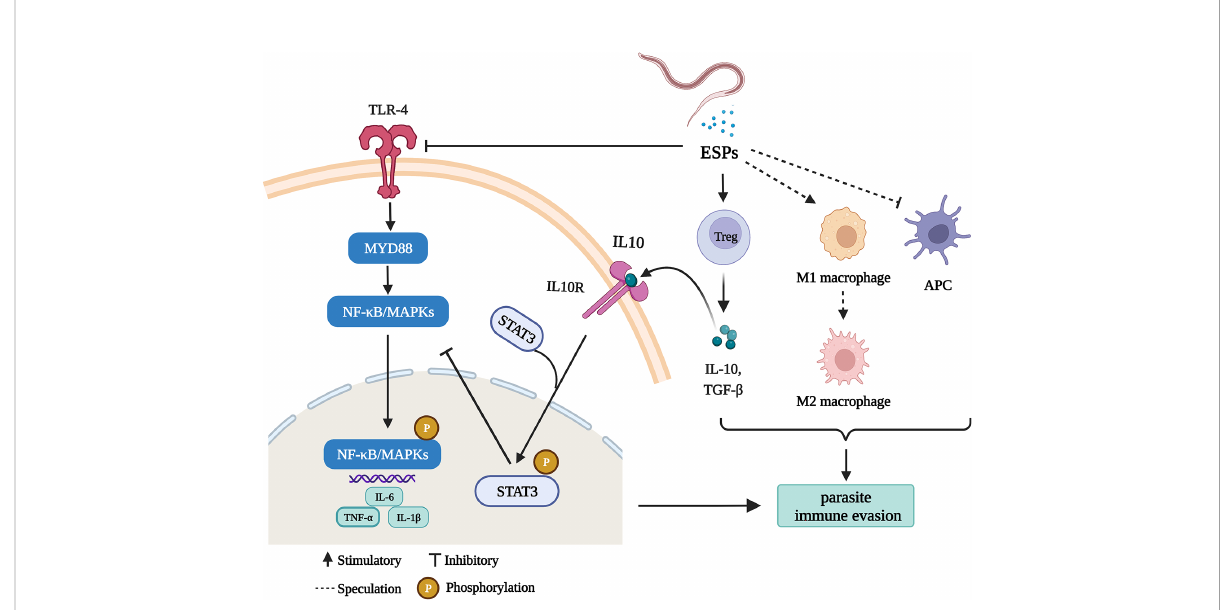
FIGURE 8 HcESPs suppress goat immune function: a possible mechanism of immune evasion in Haemonchus contortus (Charting with BioRender.com software). HcESPs suppress adaptive immunity by upregualtion of Treg cells, inhibiting the antigen presenting cells, and promoting the shift of macrophages from pro-in fl ammatory type (M1) to anti-in fl ammatory type (M2). In addition, HcESP suppresses innate immunity by inhibiting TLR4//NF- k B pathway and activating IL-10/STAT3 pathway, which result in downregulated in fl ammatory